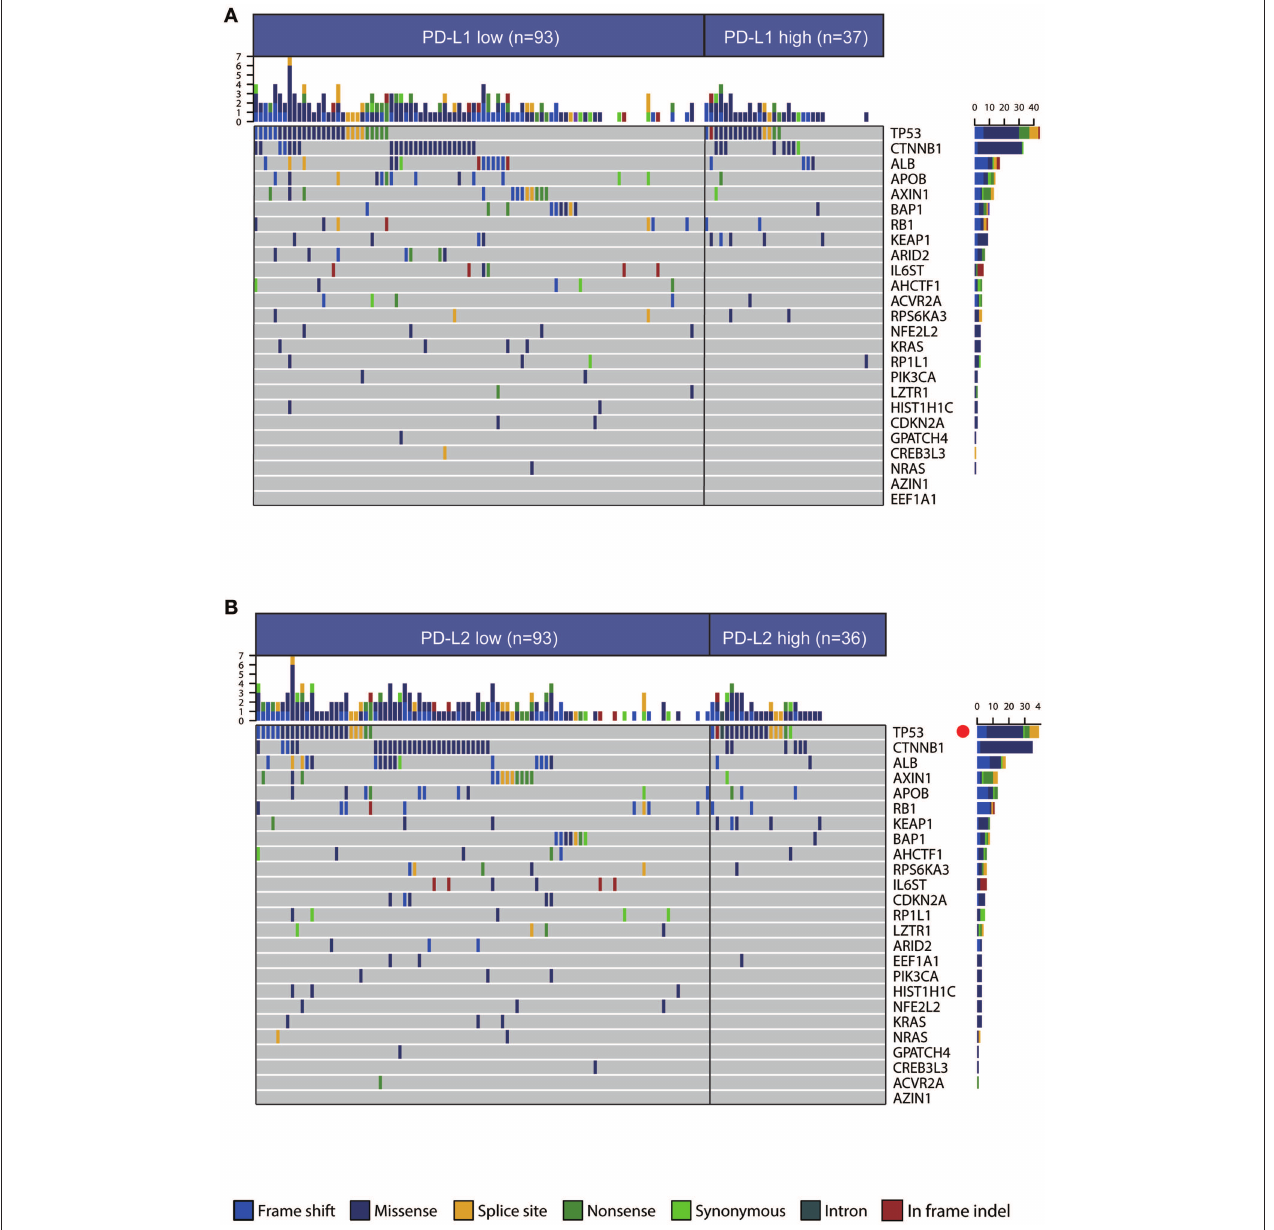
FIGURE 4 | Association between PD-Ls and mutational signatures in HCC. (A,B) Significantly mutated genes in HCC subsets stratified by PD-L1 (A) and PD-L2 (B) expression. Red dot, P <